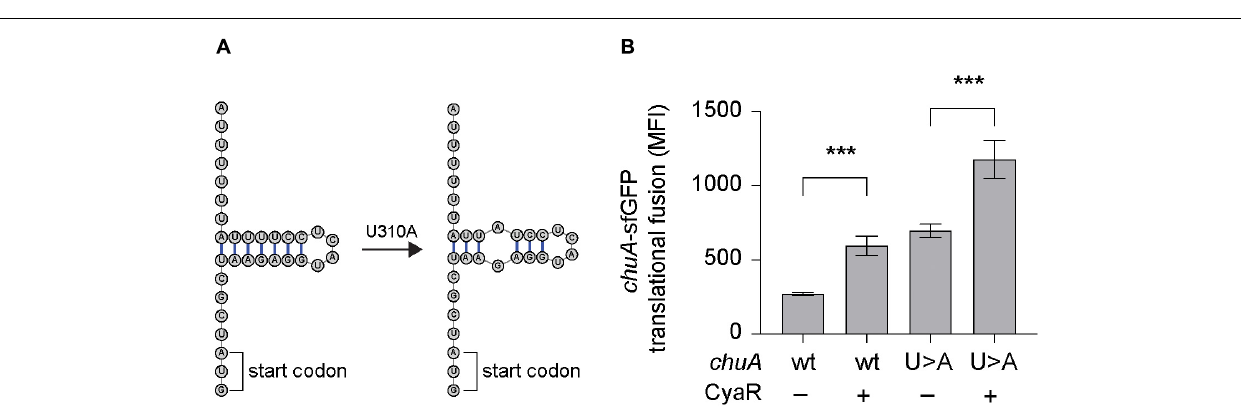
FIGURE 3 | CyaR activates chuA translation independently of a FourU RNA-thermometer. (A) Diagram indicating the point mutation made to disrupt the formation of the chuA FourU RNA thermometer. (B) Fluorescence measurements of wild-type and RNA-thermometer disrupted chuA- sfGFP translational fusions in the presence and absence of CyaR overexpression plasmid. Measurements are the mean median fluorescence intensity of three biological replicates (*** p <